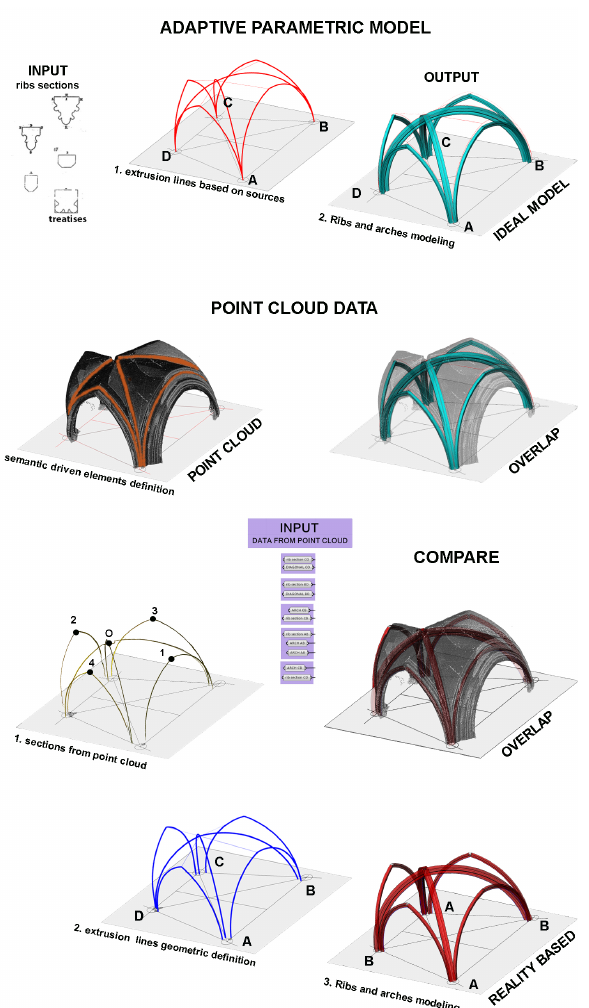
Figure 11 . Tool test for trapezoidal Church of S. Lorenzo vault. Comparison between ideal model and reality based model